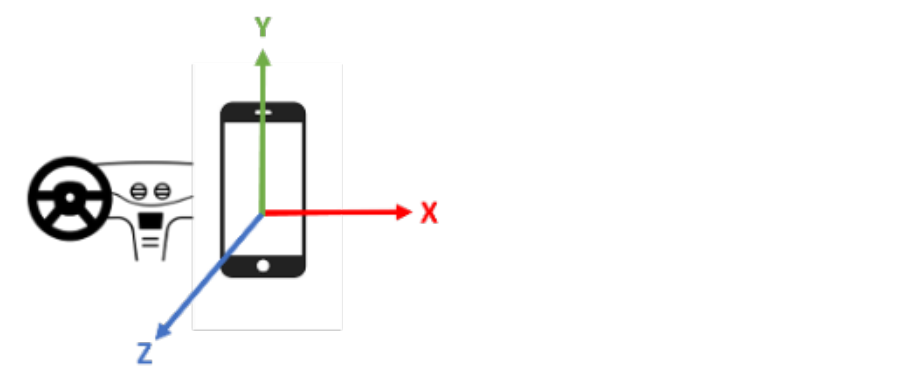
( c ) Figure 3. ( a ) The home page of the recording interface; ( b ) recording new route: four types of road states are available (Potholed, Bumps, Smooth and Other); ( c ) an example of selecting a label before starting recording.